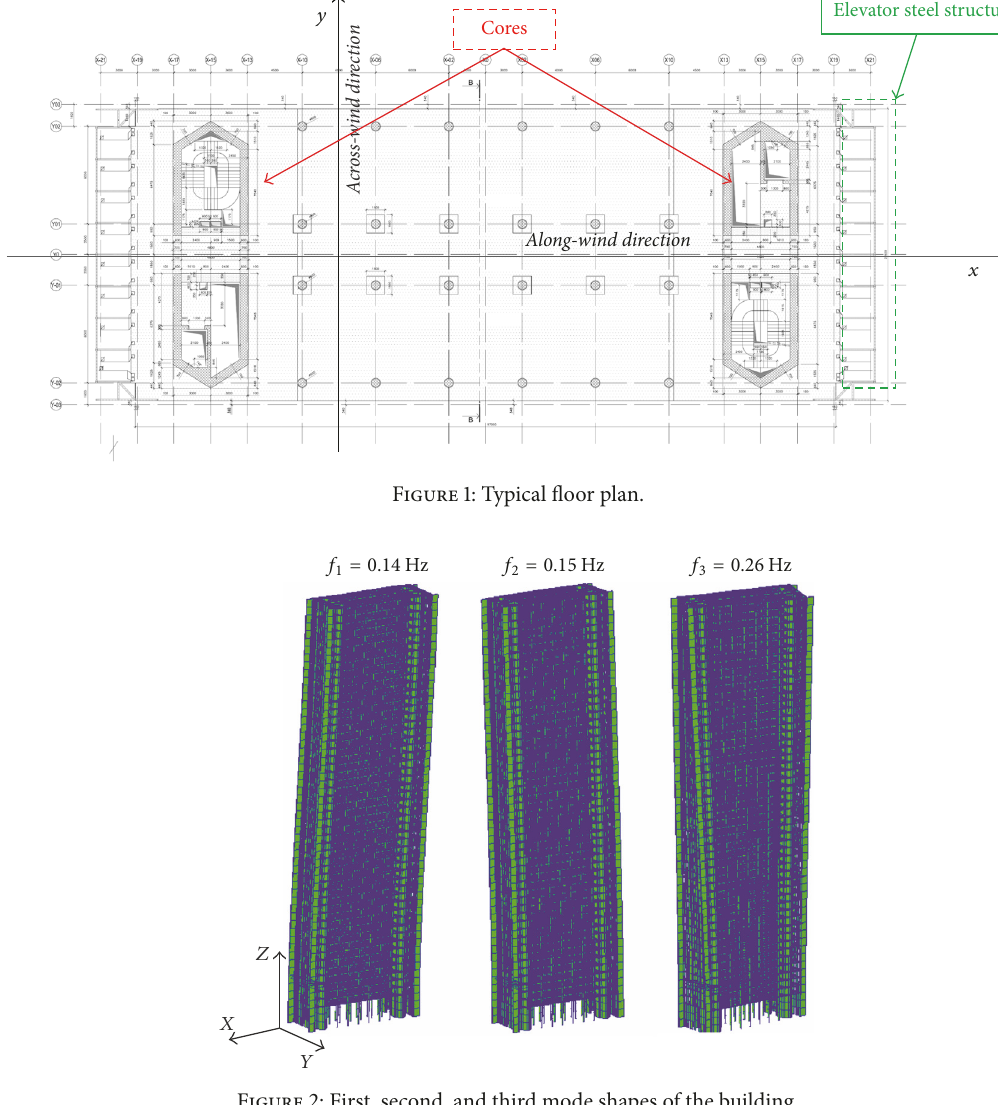
Figure 2: First, second, and third mode shapes of the